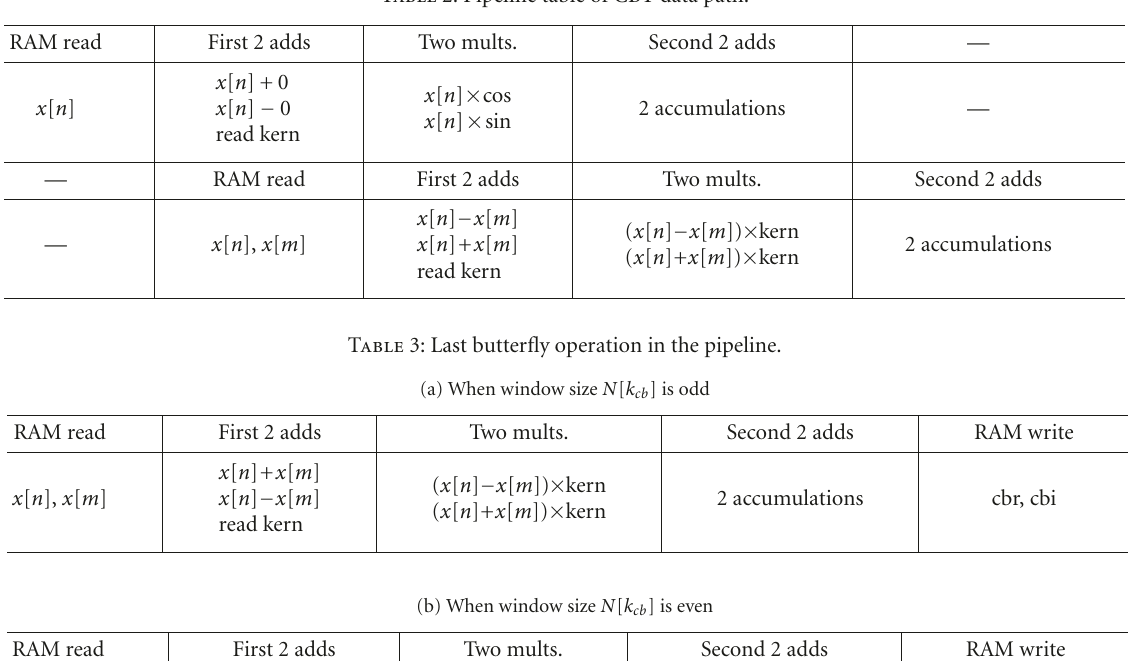
Table 2: Pipeline table of CBT data path.